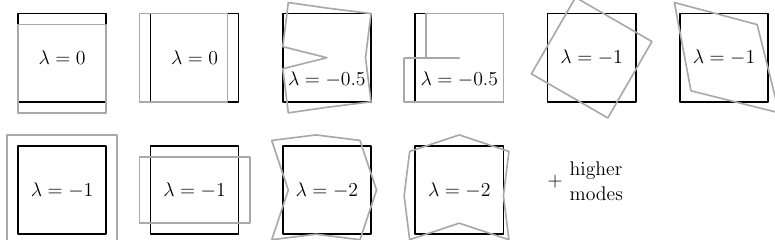
Figure 3. Graphical representation of modes. In black the original domain with linear elements and in gray the modes with corresponding